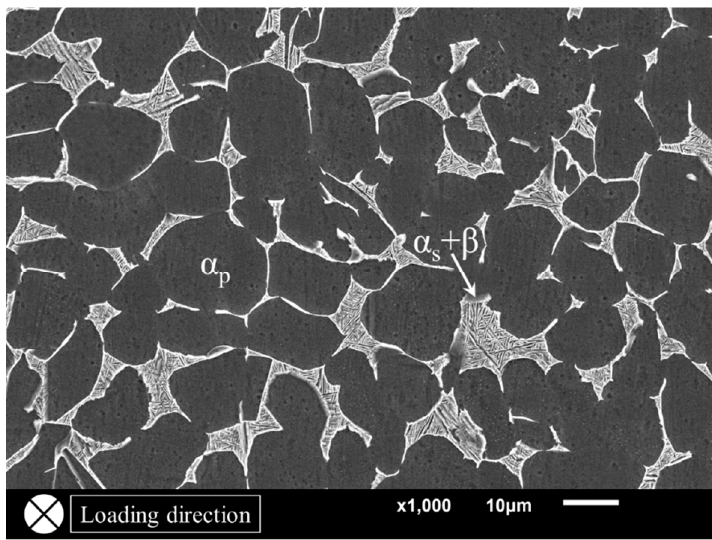
Figure 1. The microstructure of the Ti ‐ 8Al ‐ 1Mo ‐ 1V alloy. The testing surface corresponds to a transversal section of fatigue specimens.